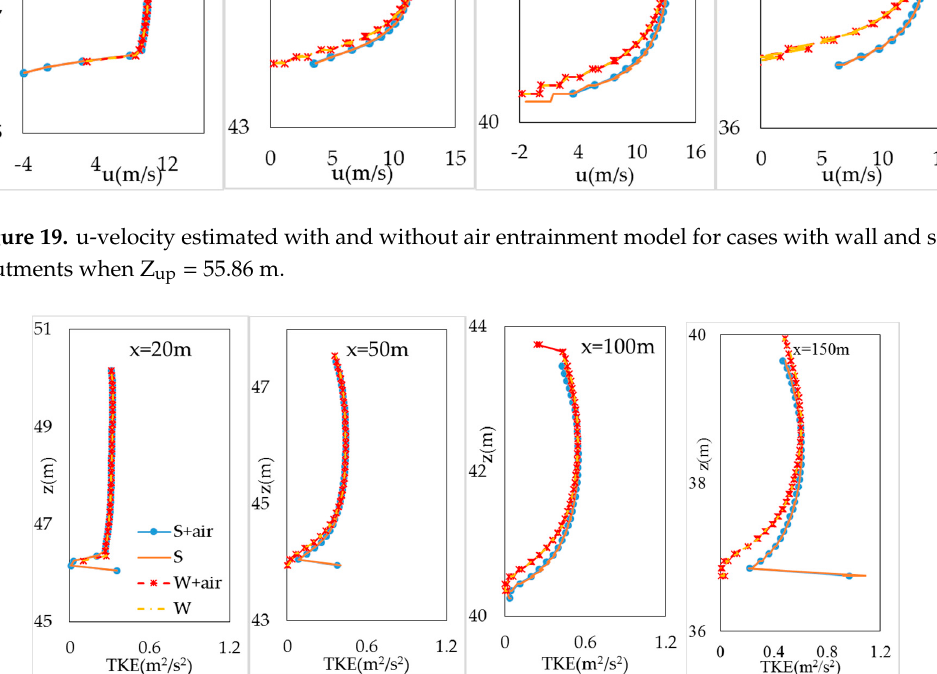
Figure 21. TKE estimated with the air entrainment model for both cases wall (W) and step (S) abutments at x = 20m; 50m; 100m and 150m when Z up = 52 m. In a skimming flow regime, the steps cause more friction and a larger roughness layer. Most of the engergy is dissipated to maintain stable vortices beneath the pseudo-bottom formed by the external edges of the steps. The vortices are maintained through the transmission of turbulent shear stress between the skimming stream and the recirculating fluid underneath. According to Chanson [15], energy loss in an ungated spillway and channel chute can be estimated by Equation (5): 1/3